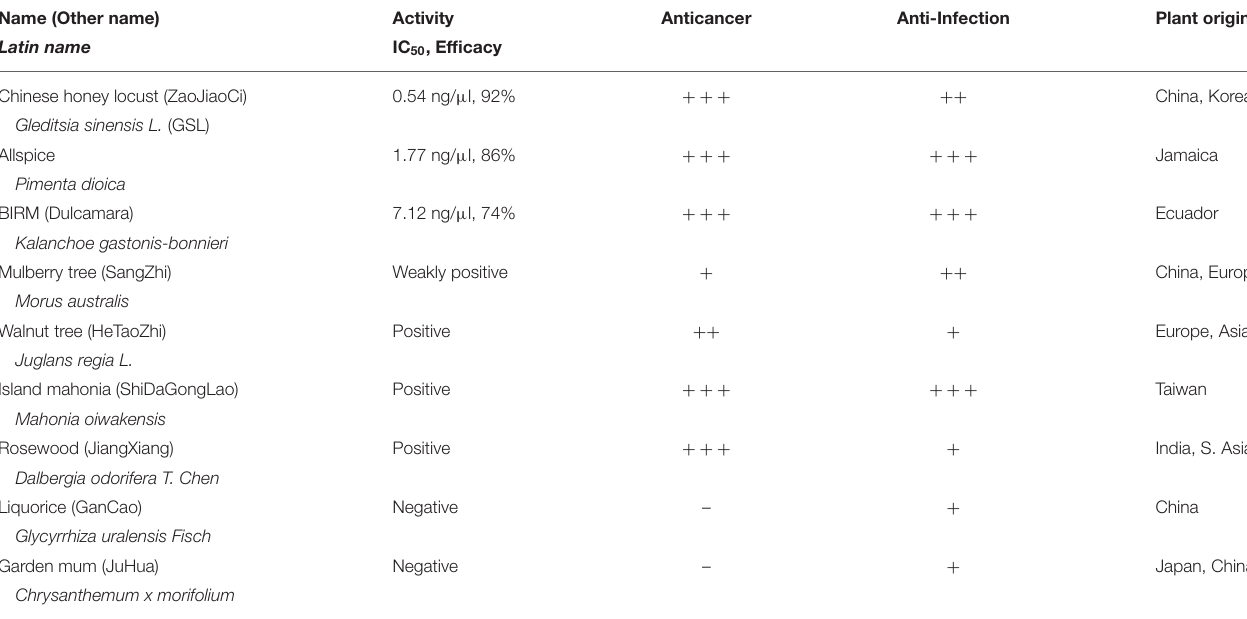
TABLE 2 | Summary of herbs tested for GT198